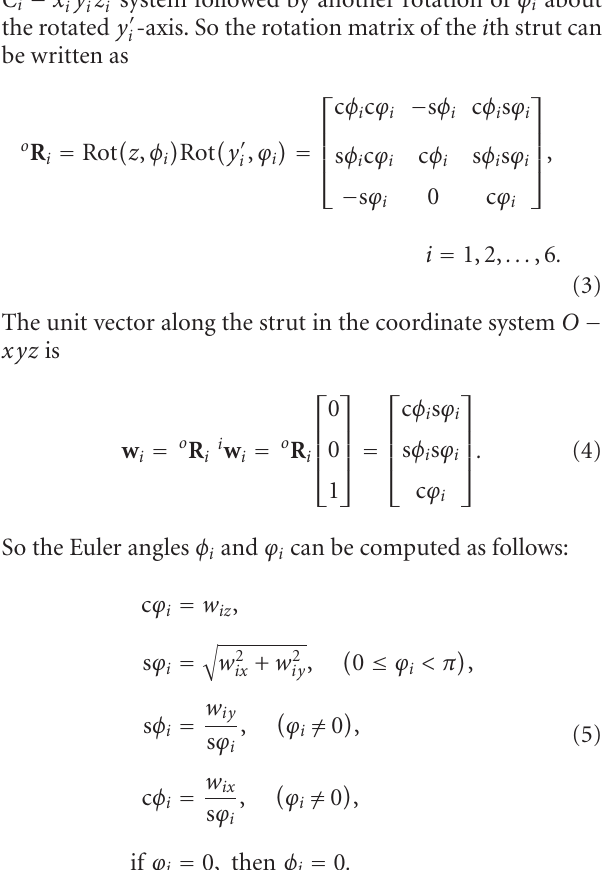
where s φ denotes the sine of angle φ , and c φ denotes the cosine of angle φ . In the hypothesis of small rotations, the angular velocity of the moving platform is given by [24,